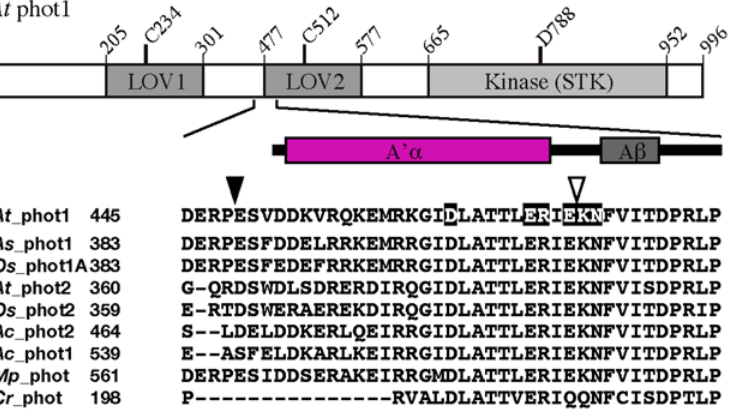
Fig 1. Schematic drawing of At phot1 (upper panel) and the secondary structure around A ’ α -helix region. Alignment of the amino acid sequences of phot in the A ’ α -helix regions using ClustalX. Arabidopsis thaliana , At ; Avena sativa , As ; Oryza sativa , Os ; Adiantum capillus-veneris , Ac ; Marchantia , polymorpha , Mp ; Chlamydomonas reinhardtii , Cr . Filled and open arrow heads indicate the N-ends of LOV2-STK and Δ A ’ α constructs, respectively. Amino acid residues substituted in this study are